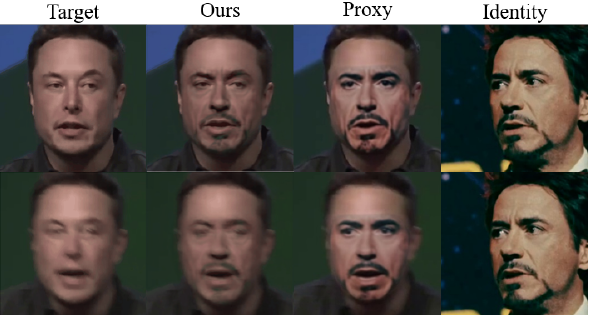
Figure 7. Examples of attributes preservation. The first row shows that our method can inherit gaze direction from the target. The second row shows that our method can preserve the same motion blur as the